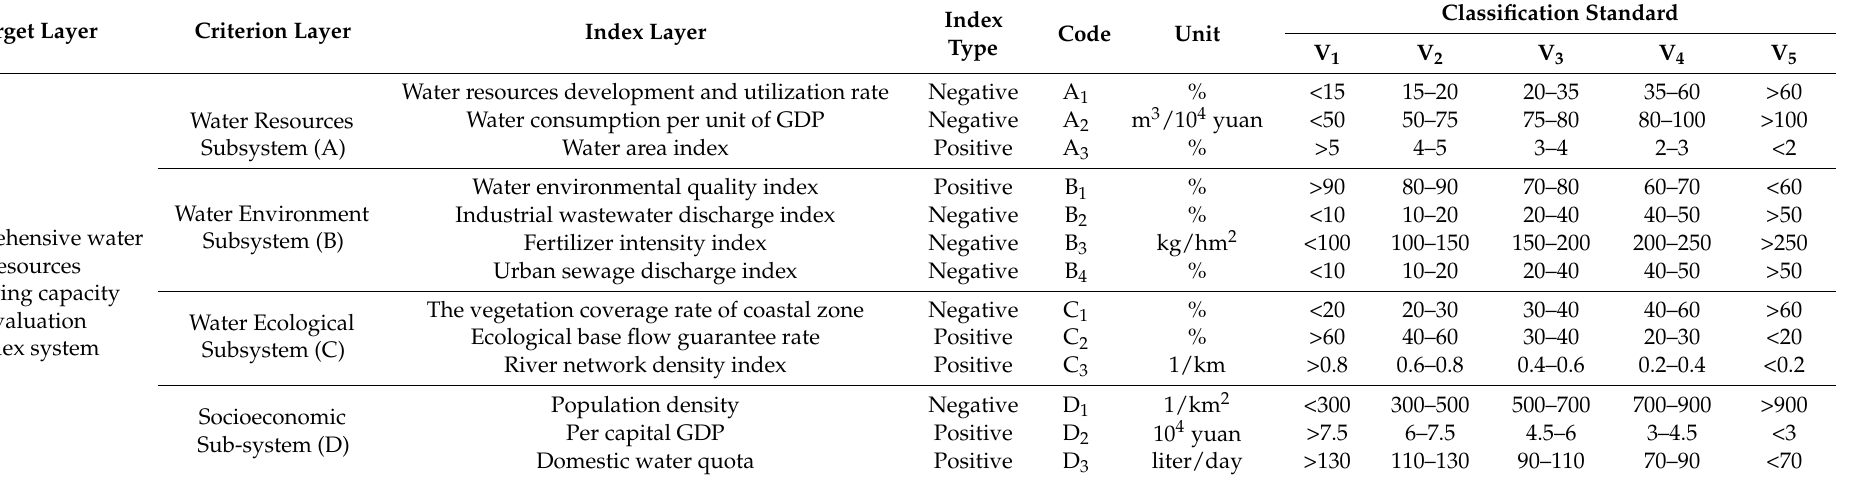
Table 1. Comprehensive evaluation index and classification standard of water resources carrying capacity in Zanhuang